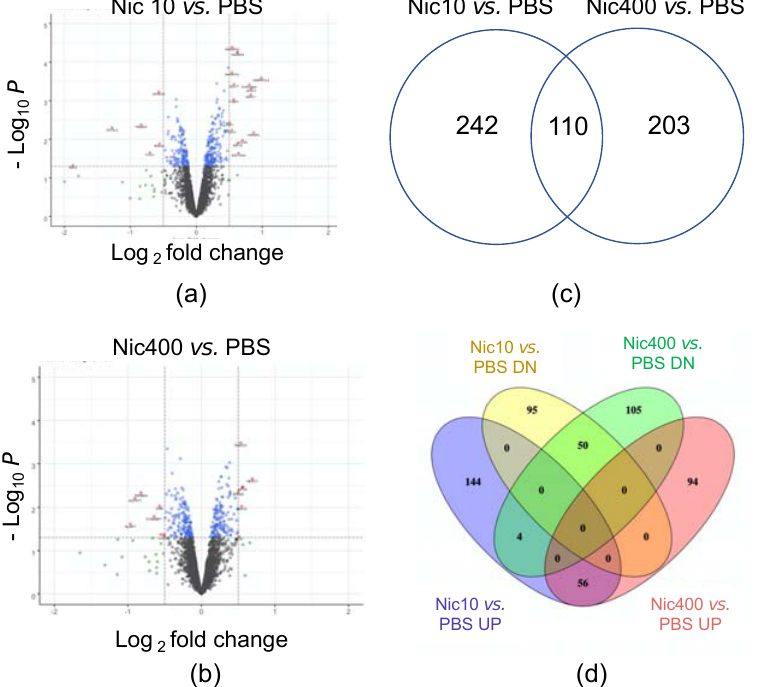
Figure 1. Volcano plots and Venn diagrams for the proteomics analysis. ( a ) Volcan plot for the 10 (Nic10) µ g/mL of nicotine vs. PBS comparison; ( b ) volcano plot for the 400 (Nic400) µ g/mL of nicotine vs. PBS comparison; ( c ) Venn diagram comparing proteins in the Nic10 and Nic 400 groups; ( d ) Venn diagram comparing up ‐ and downregulated proteins in the Nic10 and Nic400 groups. In volcano plots, black dots = proteins not significantly affected by treatment; blue dots = significantly affected proteins with a log2 fold ‐ change of >0.1; red dots = significant affected proteins with a log2 fold ‐ change of >0.5.